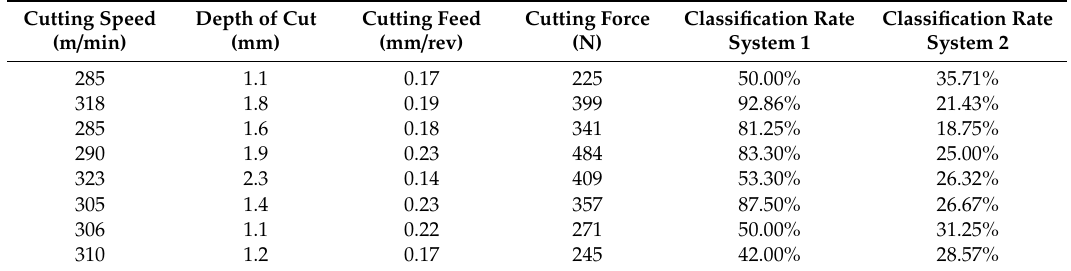
Table 12. Classification results of comparative